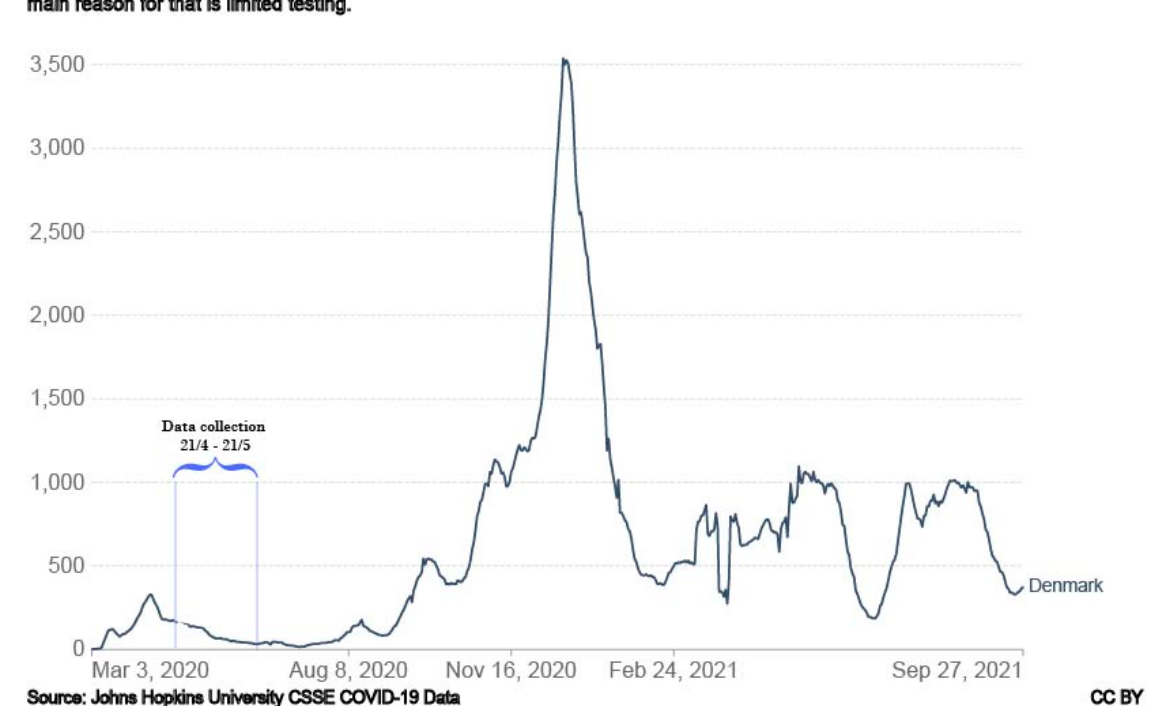
Figure 1. Daily confirmed COVID-19 cases.